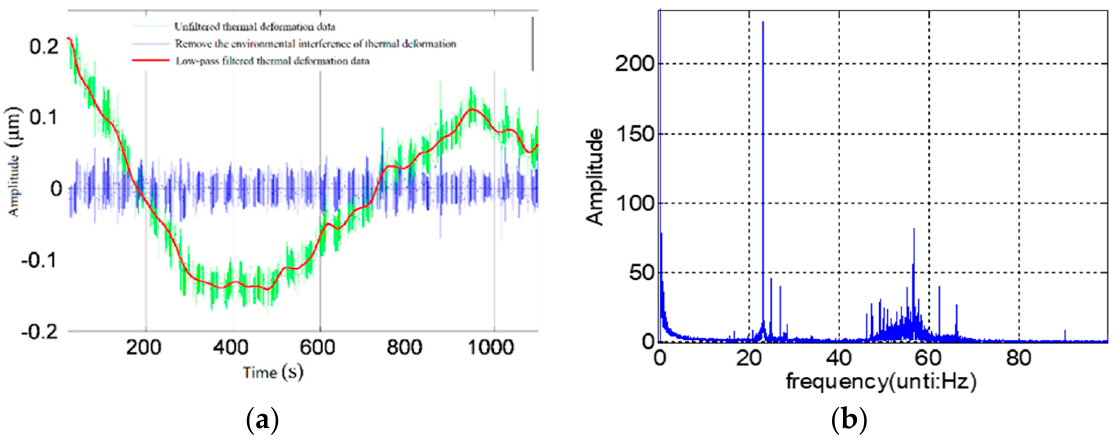
Figure 4. The influence of environmental factors when the spindle ( a ) Influence of ambient tempera-